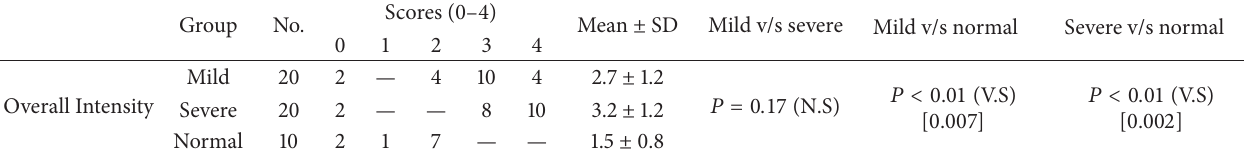
Table 5: Pattern of overall intensity of vimentin scores in mild OSF cases, severe OSF cases, and control group. Group No. Mild Overall Intensity